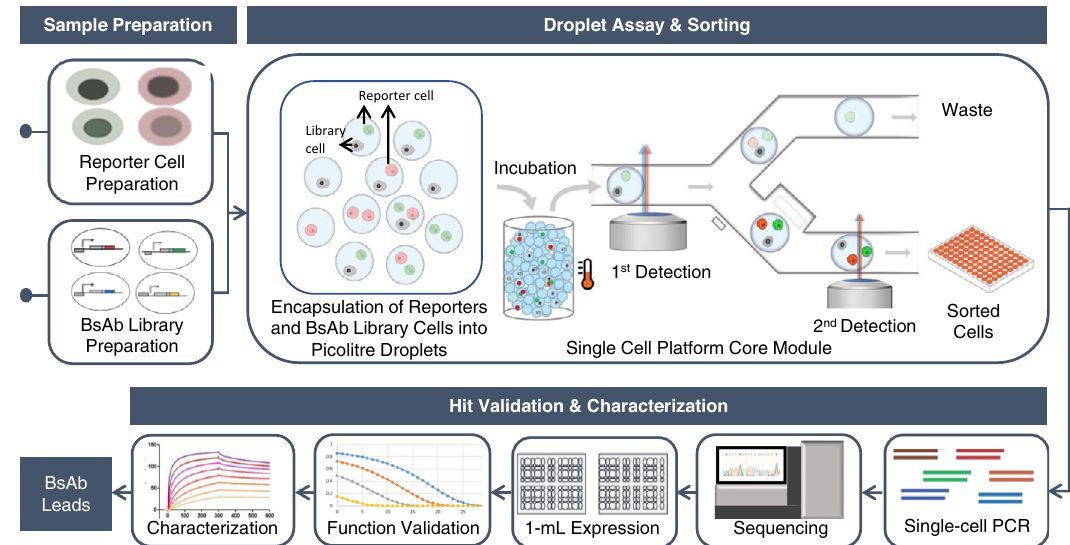
Fig. 1 Overview of single-cell-based BsAb discovery pipeline. The schematics depicts the different steps of the micro fl uidics platform used for BsAb discovery, from sample preparation (reporter cell and BsAb library cells), droplet assay and detection/sorting followed by downstream single-cell PCR, sequencing, protein expression and functional validation/characterization of sorted